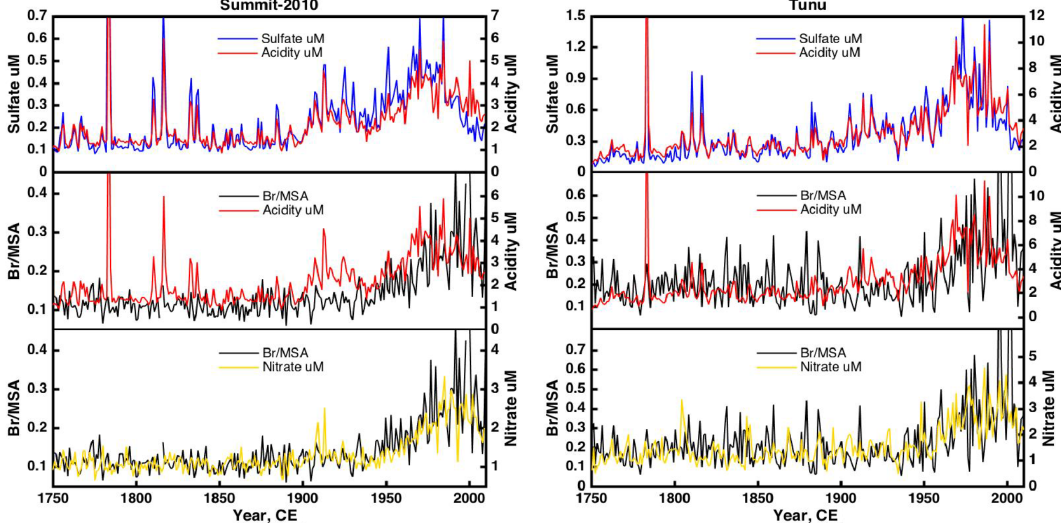
Figure 4. Comparison between the measured total sulfur (shown as sulfate) and acidity records from each ice core (top panels). The acidity record is dominated by the influence of the sulfur species until the early 21st century when the NO x pollution remains elevated whilst anthropogenic sulfur sources are depleted resulting in a slight relative elevation of the total acidity relative to total sulfur concentrations. The large spikes in the acidity and sulfur records are identified as volcanic events. The ice core records cover the period of the 1783 Laki eruption as well as the unknown 1909 eruption and Tambora eruption (Indonesia) in 1815 (Sigl et al., 2013). Comparison between Br / MSA and total acidity (centre panels) and nitrate (NO − , bottom panels) measured in the ice cores. The Br / MSA ratio follows the total acidity record 3 closely except where the record is dominated by the sulfur component (e.g. early 1900s). Of the two major acidic species the Br / MSA follows the nitrate most closely at both ice core